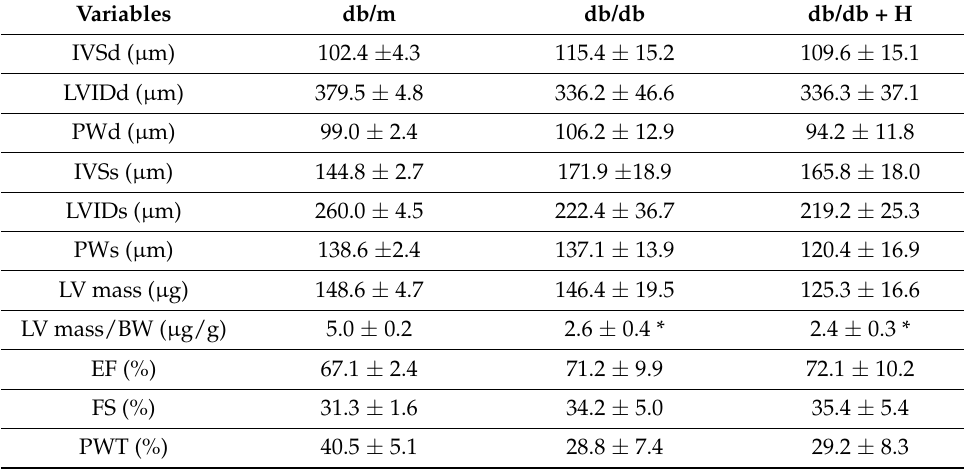
Table 3. Echocardiographic assessment and parameters evaluated in db/db mouse model. Data are expressed as mean ± SEM of each group (db/m, n = 8; db/db, n = 8; db/db + H, n = 8). * p < 0.05 vs. db/m analyzed separately by Mann–Whitney U test. Abbreviations: IVS, interventricular septum; LVID, LV internal dimension; PW, LV posterior wall. All thicknesses in diastole (d) and systole (s). BW, body weight correction; EF, LV ejection fraction; FS, LV fractional shortening; PWT, LV posterior wall thickening. Variables db/m db/db db/db + H IVSd ( µ m) 102.4 ±